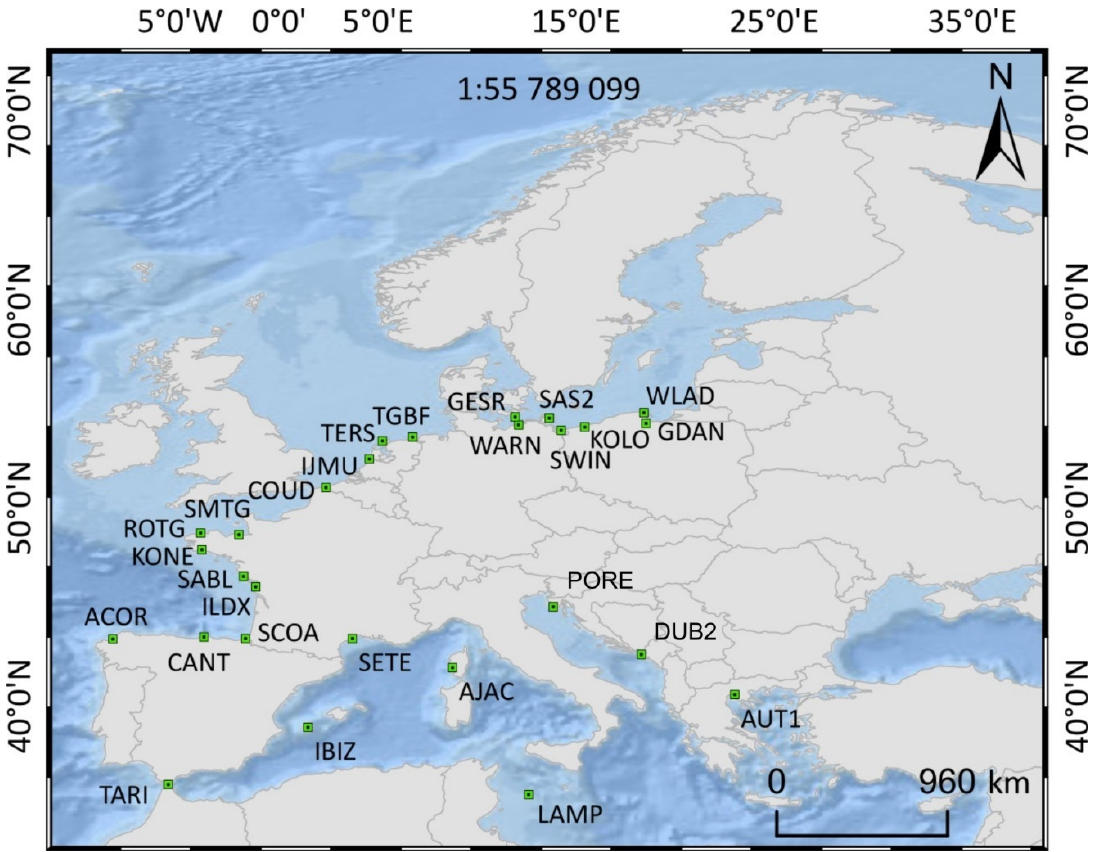
Figure 1. The location of GNSS stations which were used to determine vertical crustal movements based on TG, SA and InSAR data.